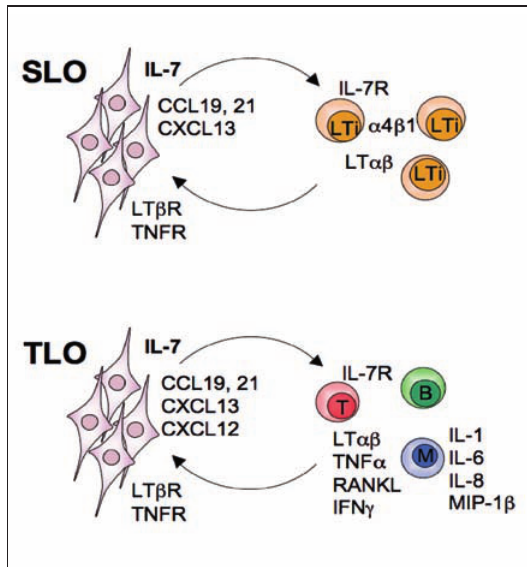
SLO and TLO devel- opment share common features. Chemokines, IL-7 and growth factors are provided by mesenchymal stro- mal cells (spindle formed). Haematopoietic cells (LTi cells, T cells, B cells, macrophages) produce cytokines and integrins, which promote stromal cell